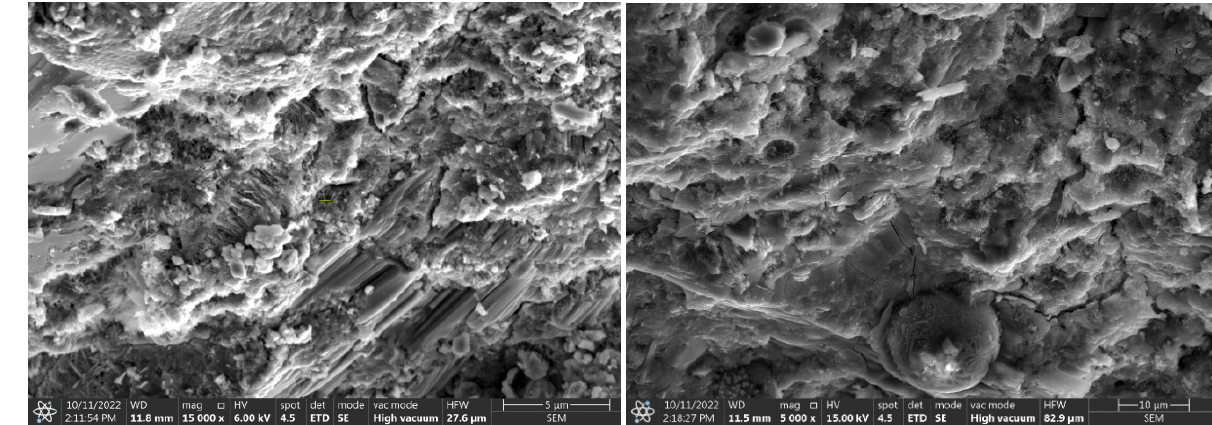
Figure 7. Microphotographs of the reference sample.